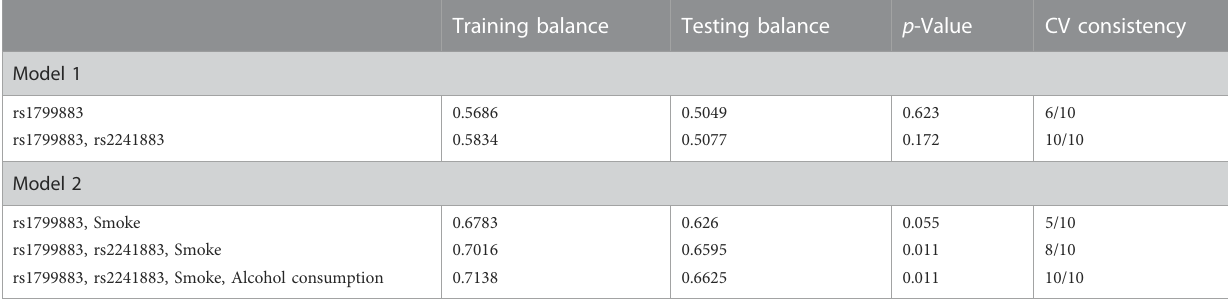
TABLE 6 Gene-gene and gene-environment interaction on ischemic